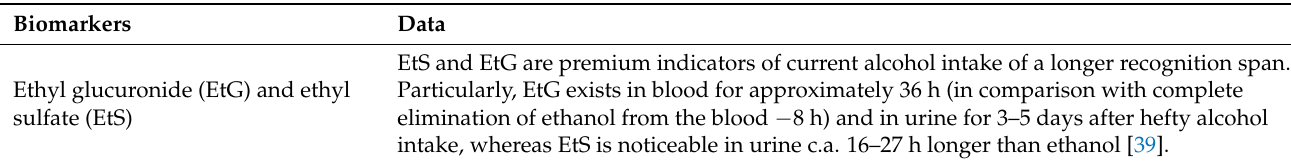
Table 4. New biomarkers of alcohol